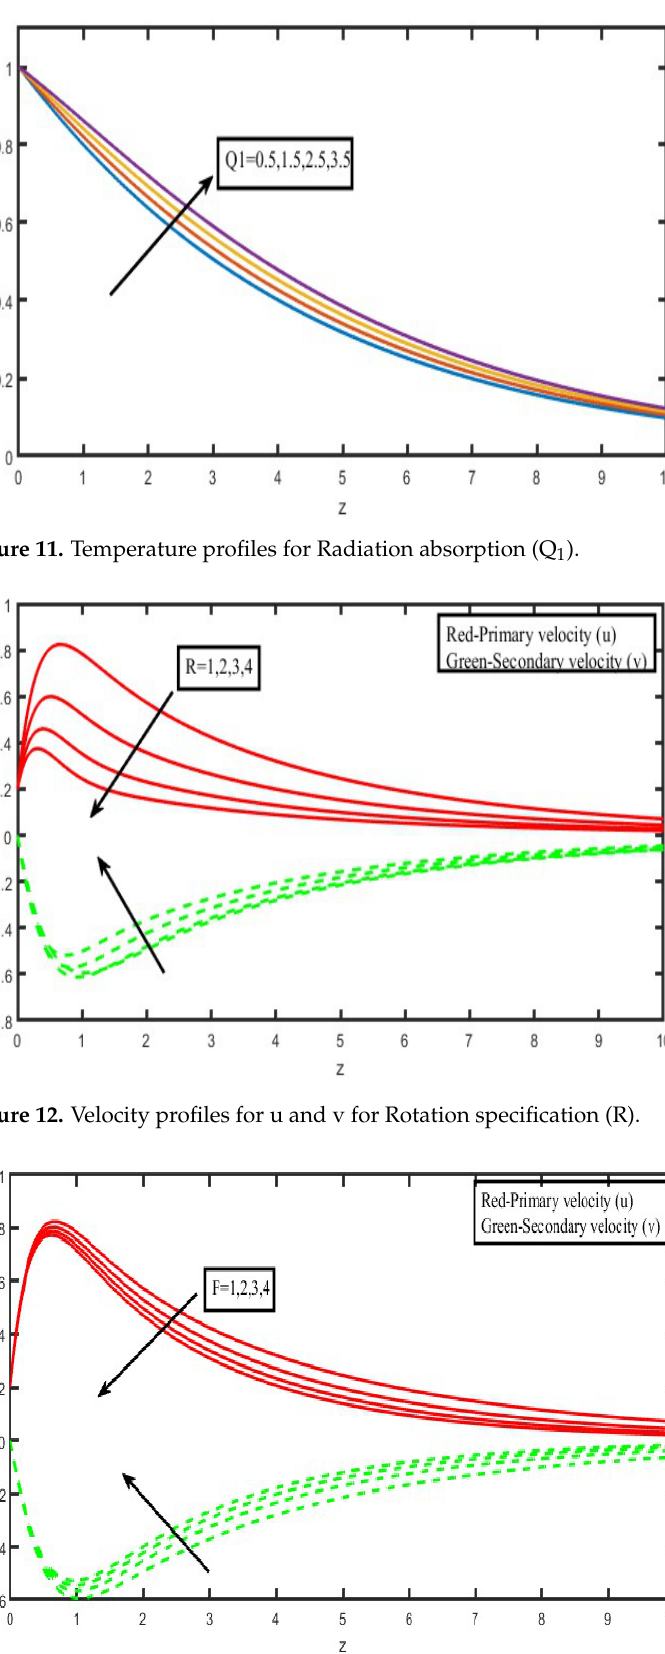
Figure 13. Velocity profiles for u and v for Radiation parameter (F).